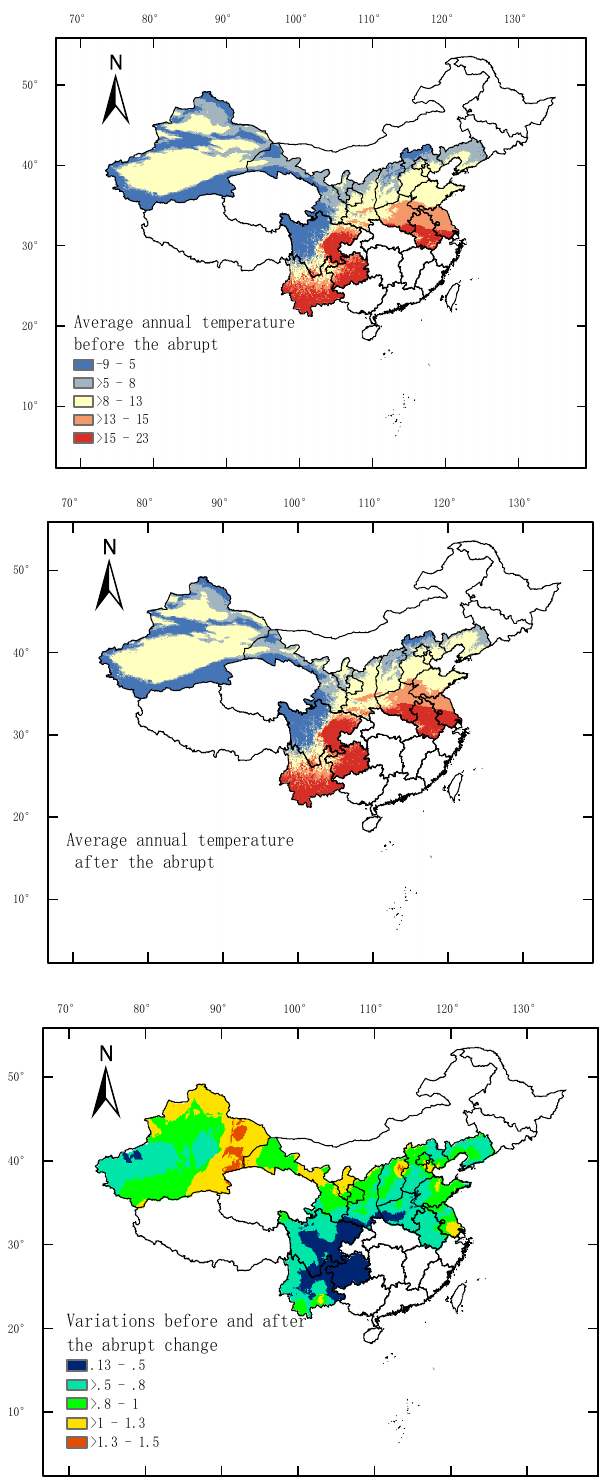
Figure 4. The changes in spatial distribution of the major apple-producing regions in China before and after the abrupt change of annual average temperature, wherein the yellow area represents the optimal range of annual average temperature for high-quality apple growing.